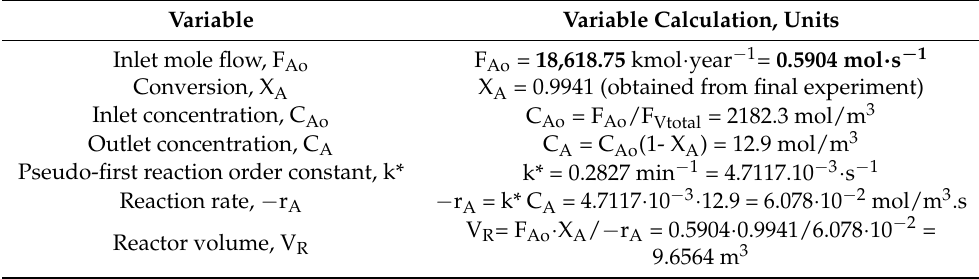
Table 9. Reactor volume determination. Variable Variable Calculation,